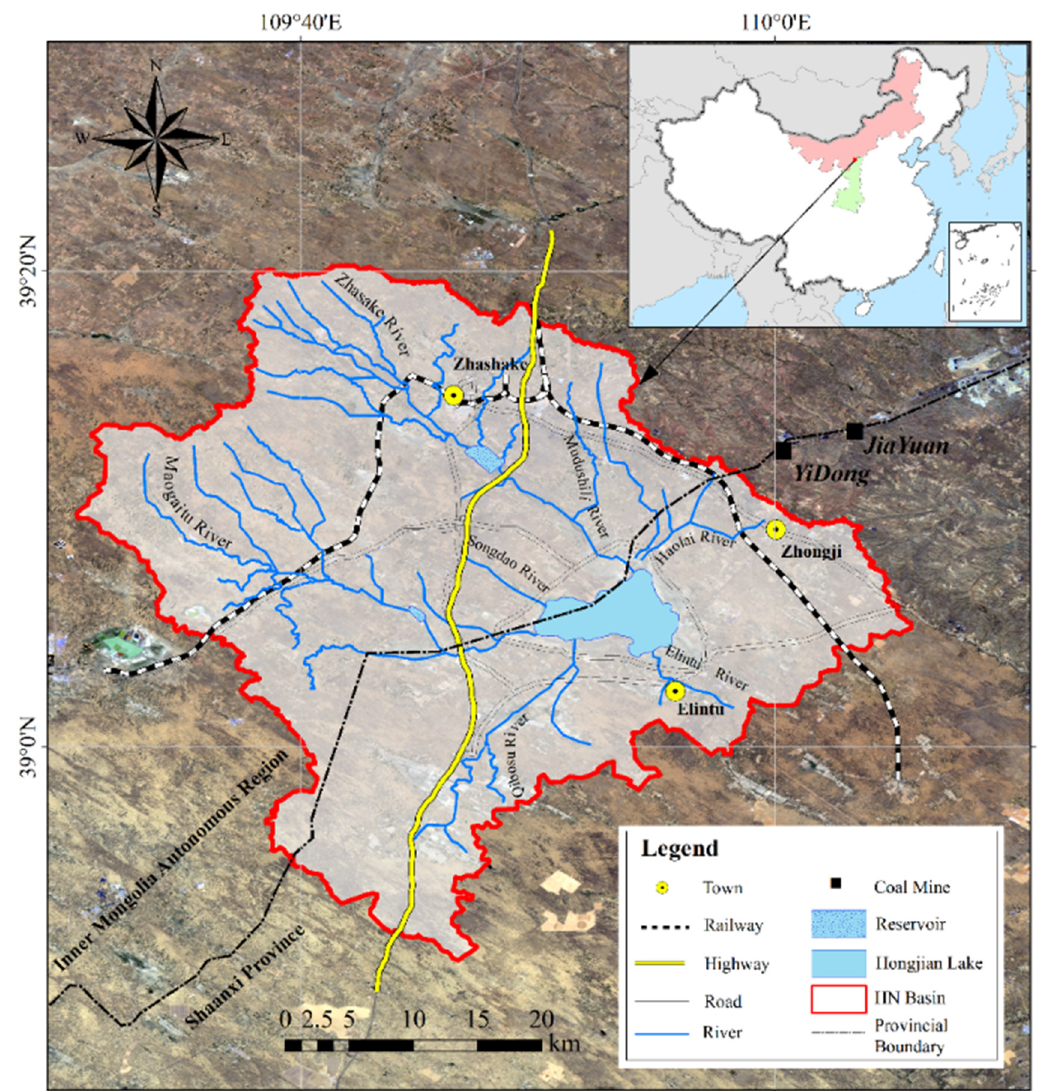
Figure 1. Map of the Hongjian Nur basin (HN basin).